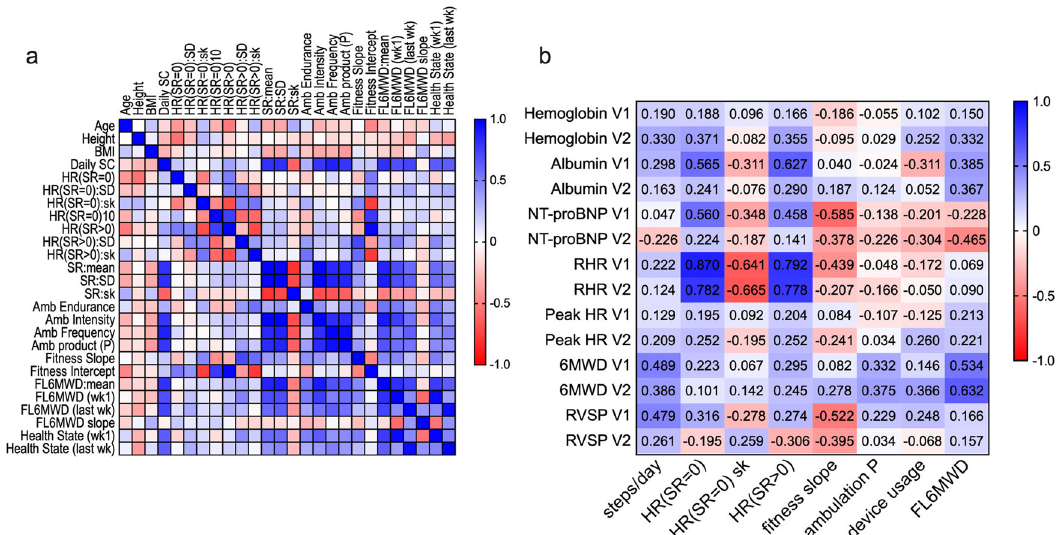
Fig. 8 Correlation amongst Fitbit-derived parameters and between Fitbit-derived parameters and clinical parameters. a Correlation matrix (Pearson r value) of all the Fitbit-derived parameters and demographic variables (age, height, and BMI). b Correlation matrix (Pearson r value) for statistically signi fi cant continuous clinical parameters (y-axis) for subgroups identi fi ed from Fitbit parameters